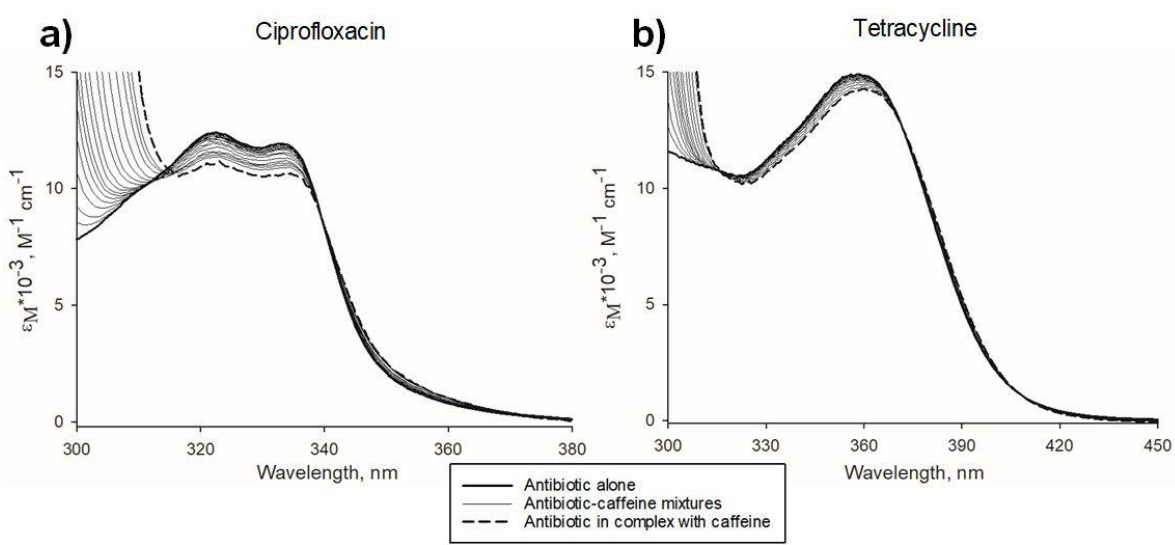
Figure 1. Spectrophotometric titrations of antibiotics with caffeine. ( a ), absorption spectra (in the form of molar extinction coefficient ε M ) of ciprofloxacin (initial concentration, 60.3 µM) titrated with caffeine (concentration range, 0.3–40.6 mM); ( b ), absorption spectra (in the form of molar extinction coefficient ε M ) of tetracycline (initial concentration, 43.2 µM) titrated with caffeine (concentration range, 0.3–21.5 mM). Spectra of an antibiotic in its free form are marked in bold. The spectra of antibiotics complexed with caffeine (calculated by extrapolation of mixture spectra to concentration ratio of antibiotic:caffeine → 0) are marked as dashed lines. For detailed composition of each tetracycline-caffeine mixture measured during spectrophotometric titration, see Table 1. Table 1. Concentrations of all components present in tetracycline-caffeine mixtures during spectrophotometric titration (experimental and calculated with Zdunek et al. model [32]).